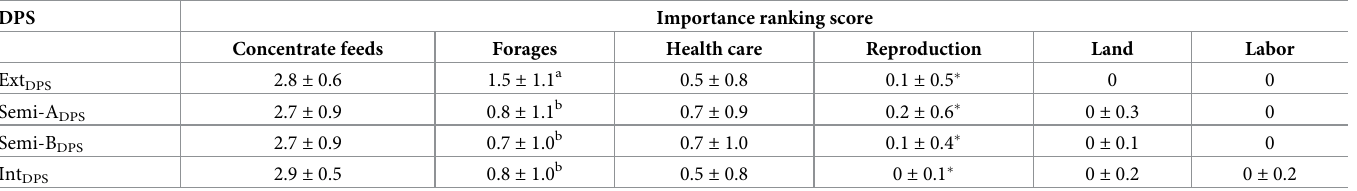
Table 1. Importance ranking scores of expenses related to dairy production with 3 = first expense, 2 = second expense, 1 = third expense and 0 = not an expense.